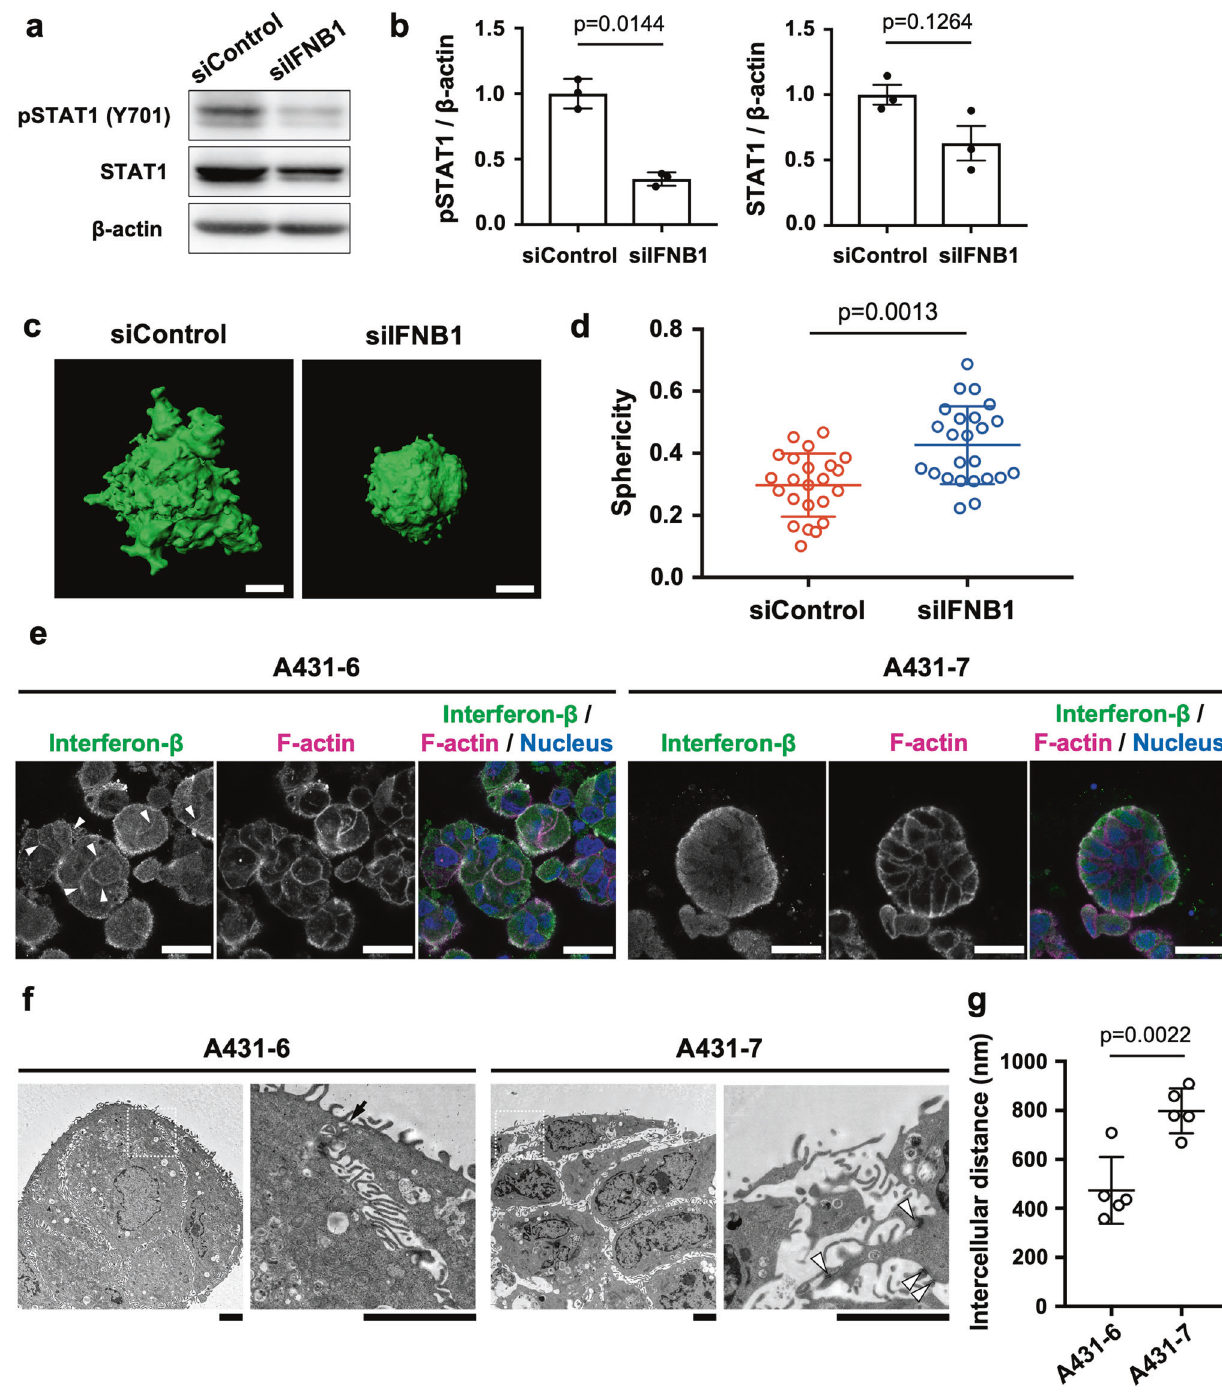
Fig. 4 Interferon- β promotes the collective invasion of cancer cells with sealed intercellular spaces. a Representative western blotting images for pSTAT1 (Y701), STAT1, and β -actin in siControl- or siIFNB1 -treated A431-6 cells. b Quanti fi cation of protein bands in ( a ). Bars represent the mean ± SEM of three independent experiments. c Representative three-dimensional constructed images of siControl- or siIFNB1-treated A431-6 cell clusters cultured in a three-dimensional collagen gel culture system. The sphericity of siControl: 0.147 and siIFNB1: 0.558. Scale bars represent 30 µm. d Quanti fi cation of sphericity in ( c ). Lines show the mean with SD for n = 23 (siControl) and n = 24 (siIFNB1) clusters by two independent experiments. e Immuno fl uorescence images for interferon- β (INFB; green) with F-actin (magenta) and nucleus (blue) in A431-6 and A431-7 cell clusters in a three-dimensional collagen gel culture system. Arrowheads show immunoreactivity for IFNB in the intercellular spaces. Scale bars represent 25 µm. f Transmission electron microscopy of A431-6 and A431-7 cell clusters cultured in a three- dimensional collagen gel culture system. The regions surrounded by the white dotted squares are magni fi ed on the right. The arrow shows the sealed edge of the intercellular space. Arrowheads show intercellular junctions. Scale bars represent 3 µm. g Quanti fi cation of intercellular distances in ( f ). Lines show the mean with SD in fi ve